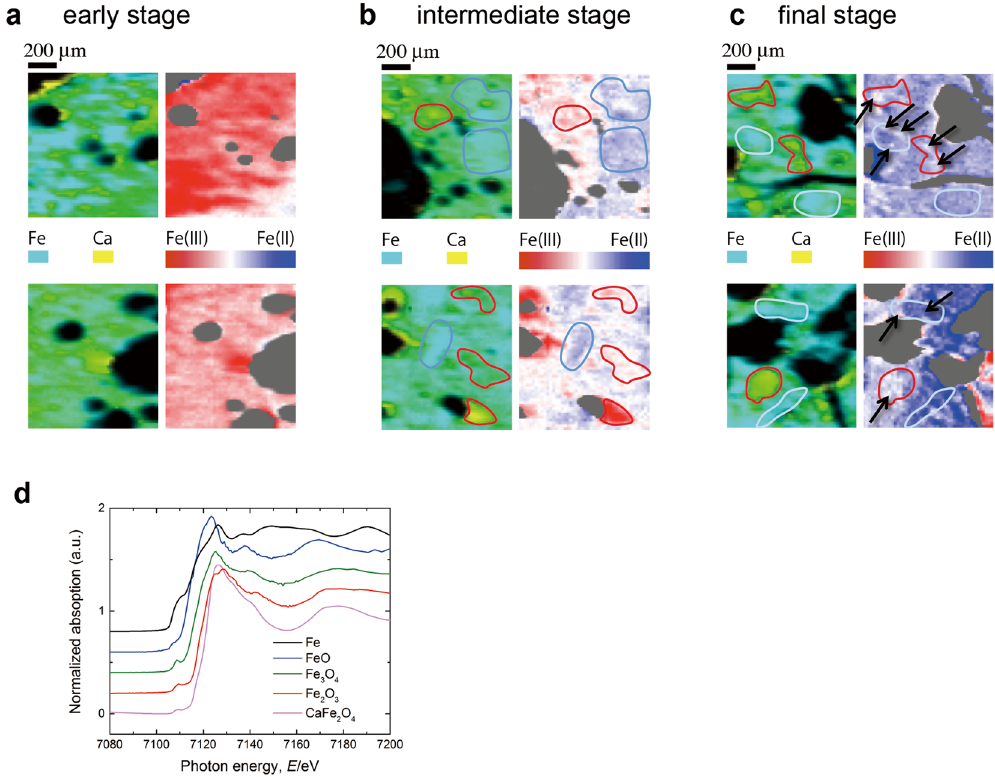
Figure 2. Chemical state mapping of an iron ore sinter. The fraction ratio of Fe(II)/(Fe(II) + Fe(III)) is color- coded: blue for 1 and red for 0. ( a ) Early (sample S-1), ( b ) intermediate (S-2), and ( c ) final (S-3) stages of reduction. The top and bottom rows show the maps for different fields of view of the same specimen for each stage. In each half-panel, the left panel illustrates the elemental distribution of iron (blue) and calcium (yellow), whereas the right panel maps the oxidation states of iron, with the Fe(III) and Fe(II) states coloured red and blue, respectively. The blue lines exemplify regions where the reduction proceeded faster than in other areas, whereas the red lines exemplify regions where the reduction was slower. Even within an area with the same calcium concentration, the reduction progressed heterogeneously, as indicated by the black arrows in Fig. 2c, where the reduction proceeded slower than the rest. ( d ) XANES spectra for standard